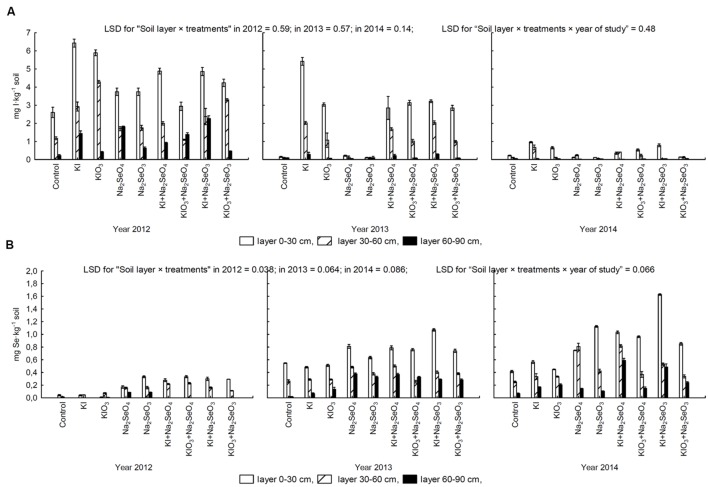
Concentration of iodine (A) and selenium (B) in 0–30 cm, 30–60 cm, and 60–90 cm soil layers after carrot cultivation in the years 2012–2014, depending on varying fertilization with iodine and selenium compounds. LSD, least significant difference, p < 0.05. Bars indicate standard error; (n = 4).